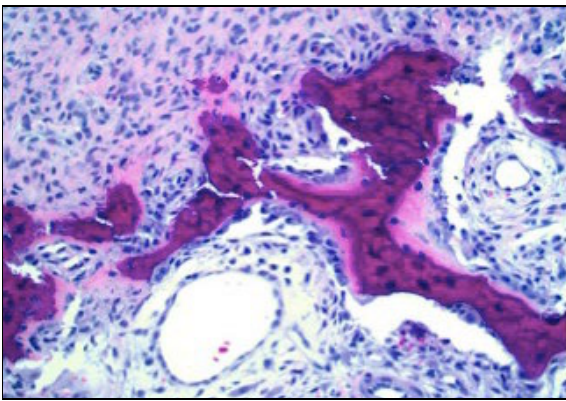
Figure 2b. Spindle cells, mineralised tissue, and dilated vascular channels (haematoxylin and eosin, magnification ×